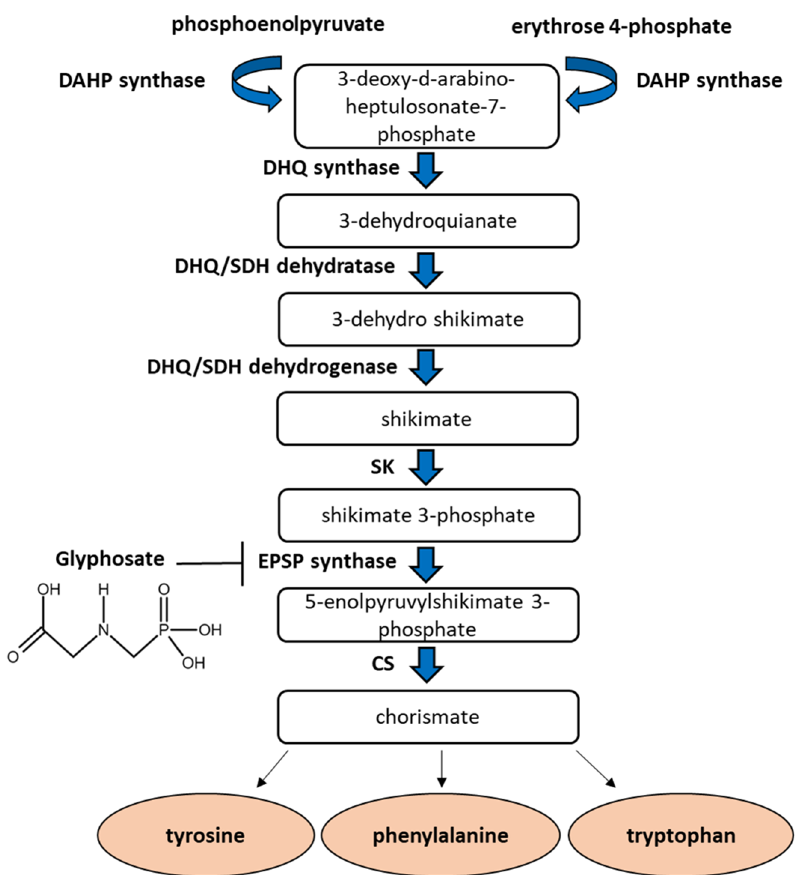
Figure 1. The shikimate pathway in plants. The shikimate pathway converts phosphoenolpyruvate (PEP) and erythrose 4-phosphate (E 4-P) into chorismate, the precursor of three aromatic